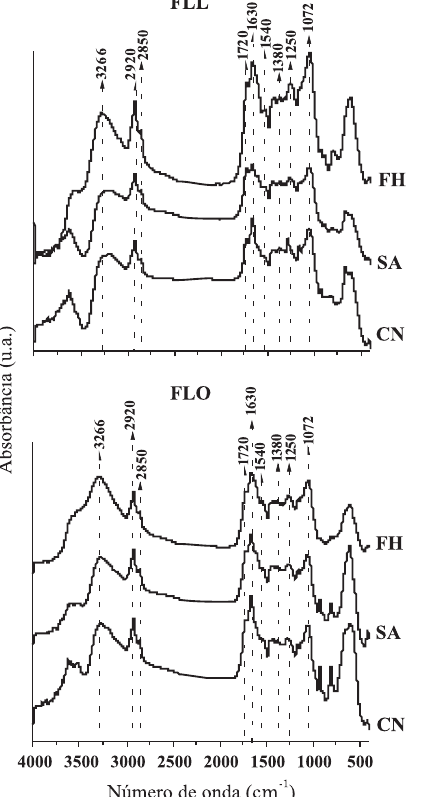
Figura 3. Espectros de Infravermelho com Transfor- mada de Fourier (FTIR) das frações leve livre (FLL) e fração leve oclusa (FLO) da matéria or- gânica de um Argissolo Vermelho submetido a diferentes sistemas de uso na camada de 0,000– 0,025 m. FH: Floresta homogênea de eucalipto; SA: Sistema agrossilvipastoril na entrelinha; e CN: Campo